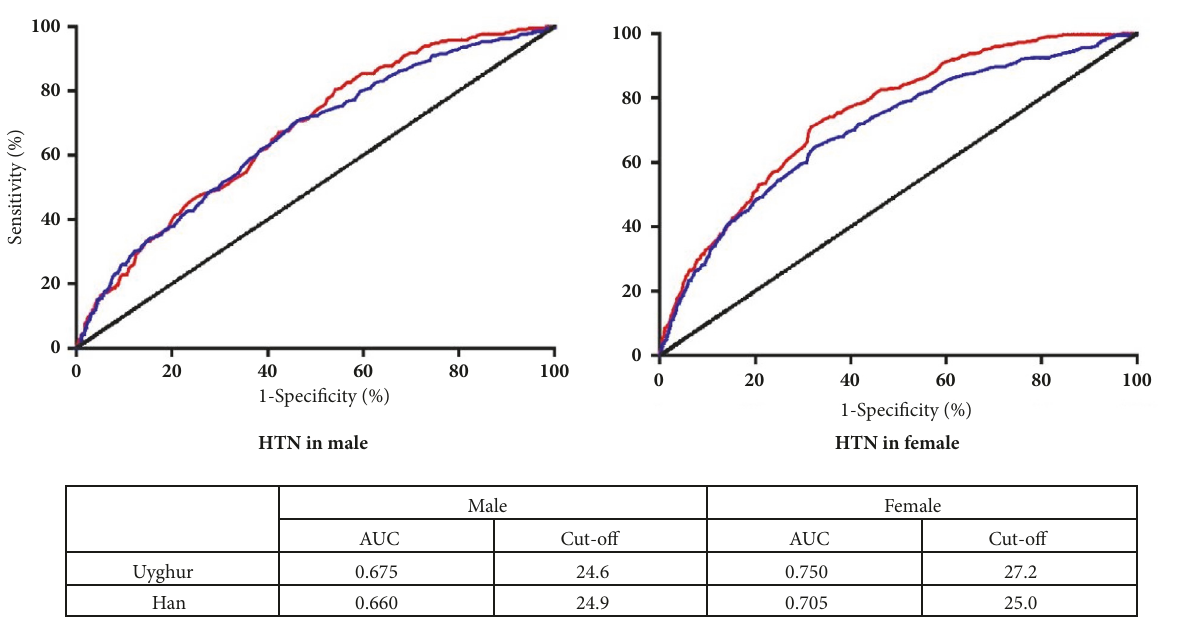
Figure 3: The ROC curves and optimal cut-off value for BMI to identify hypertension in both ethnic groups and sex. HTN: hypertension; AUC: area under the